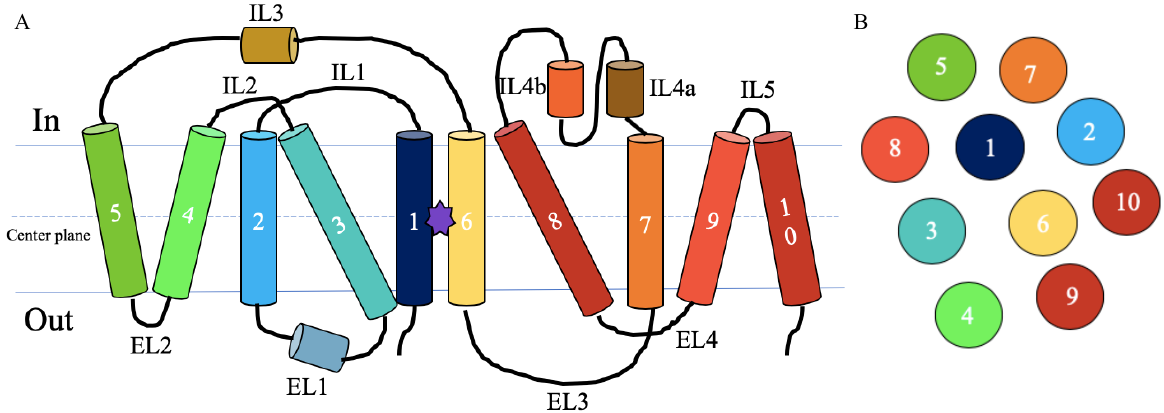
Figure 2. Schematic overview of GerAB topology. ( A ) This topology prediction is based on the structures of the three GerAB models examined in this study. The helices are shown as cylinders and the possible L-alanine binding pocket is depicted as a purple star between TM1 and 6. The figure is adapted from [24]. ( B ) illustrates the organisation of the protein from the inside of the IM. Colors of the helices depicted as circles correspond to